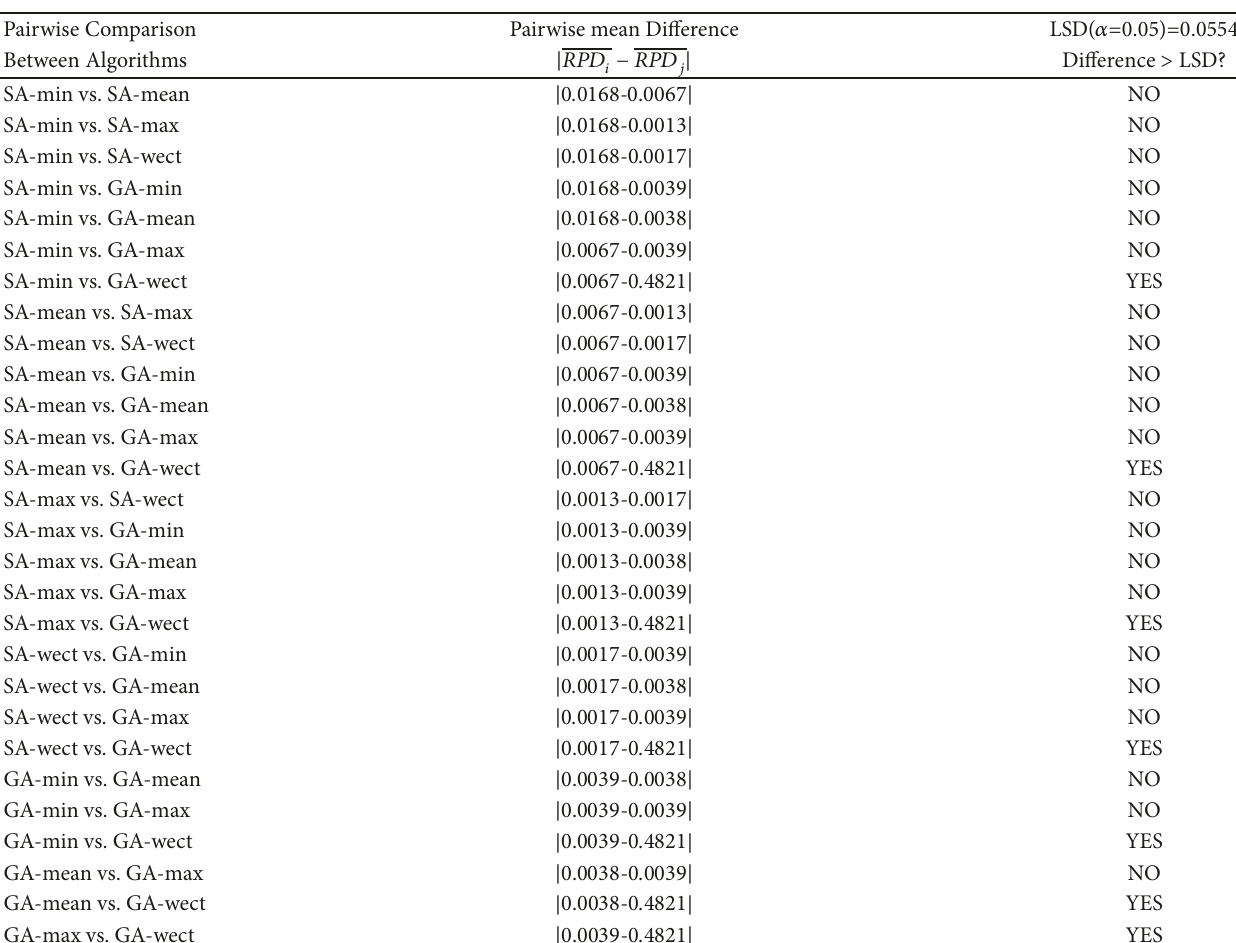
Table 9: Results of Fisher’s LSD for differences among algorithms for large number of